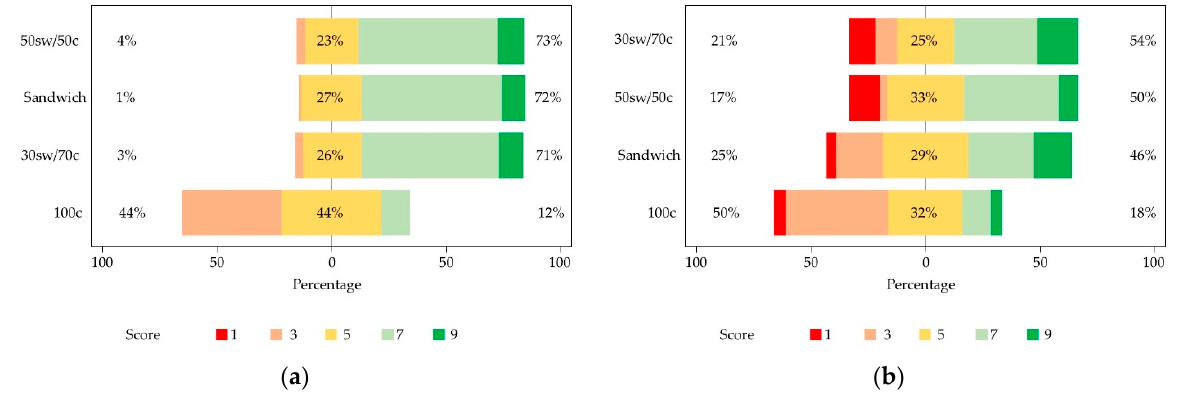
Figure 3. Influence of vegetation mats on overall impression during the course of the trial; 1 = plant failure, 3 = sufficient, 5 = satisfactory, 7 = good, 9 = very good of ( a ) 1st date of evaluation (7 July 2015) and ( b ) 7th date of evaluation (29 September 2015).